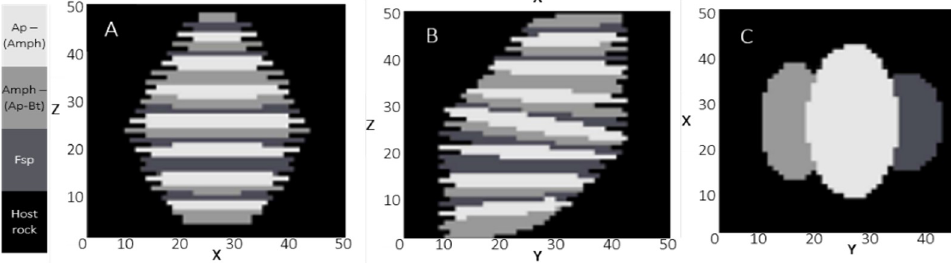
Figure 10. Spatial distribution of textural types in cross-sections generated from the synthetic ore body. A —in a plane xz , B —in a plane yz , C —in a plane xy .